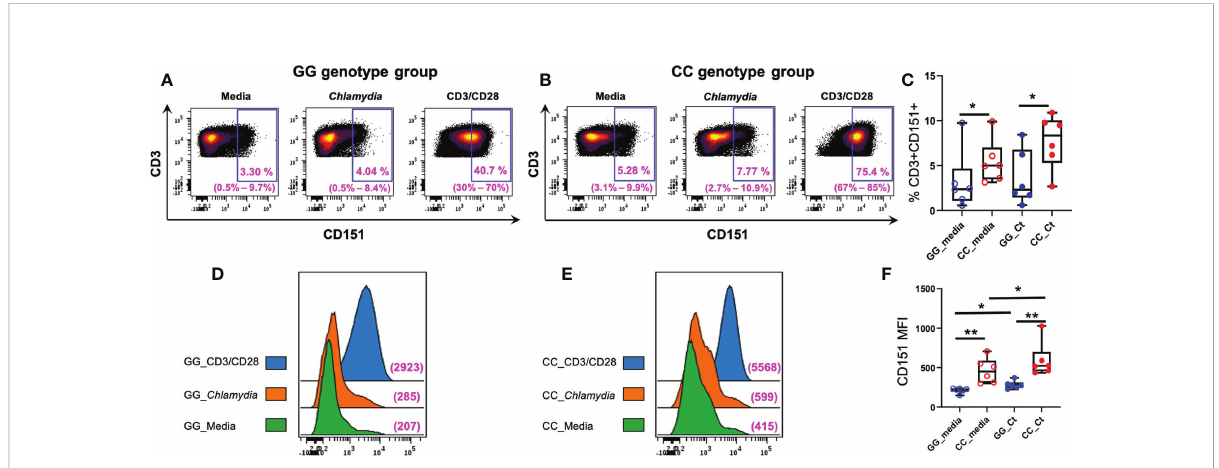
FIGURE 6 Association of CD151 genotypes with CD3+ lymphocyte CD151 expression in Ct infected women. Each dot plot is a concatenated FCS fi le consisting of CD3+ cells from six women of (A) GG and (B) CC genotypes, respectively. Range of six individual patients within each group ’ s condition is in parentheses. (C) Frequencies of CD151+CD3+ cells in GG (n = 6; blue circles) and CC genotype (n = 6; red circles) women with ( fi lled circles) and without (empty circles) Ct stimulation for 7 days. The boundaries of each box indicate the 25th and 75th percentiles; the line within each box indicates the median; whiskers indicate the 0th and 100th percentiles. Each dot represents one subject. The relative frequencies of CD3+CD151+ lymphocytes were signi fi cantly increased in the CC group with and without Ct stimulation compared to GG group by Wilcoxon Rank Sum Test. (D) Mean fl orescence intensities (MFI) of CD151 on CD3+ cells in women with GG genotype compared to women with (E) CC genotype without Ct stimulation (green histograms), after Ct stimulation (orange histograms) and after anti-CD3/CD28 stimulation (blue histograms). The x-axis indicates the fl uorescence intensity of CD151. (F) Box and whisker plots summarize the MFIs of CD151 in the different genotype groups with and without Ct stimulation. For MFI, intensities were signi fi cantly greater in the CC group compared to GG group with and without stimulation by Wilcoxon Rank Sum Test. Wilcoxon signed rank test indicated Ct stimulation signi fi cantly increased the MFI expression of CD151 in both groups, *:P < 0.05; **:P <